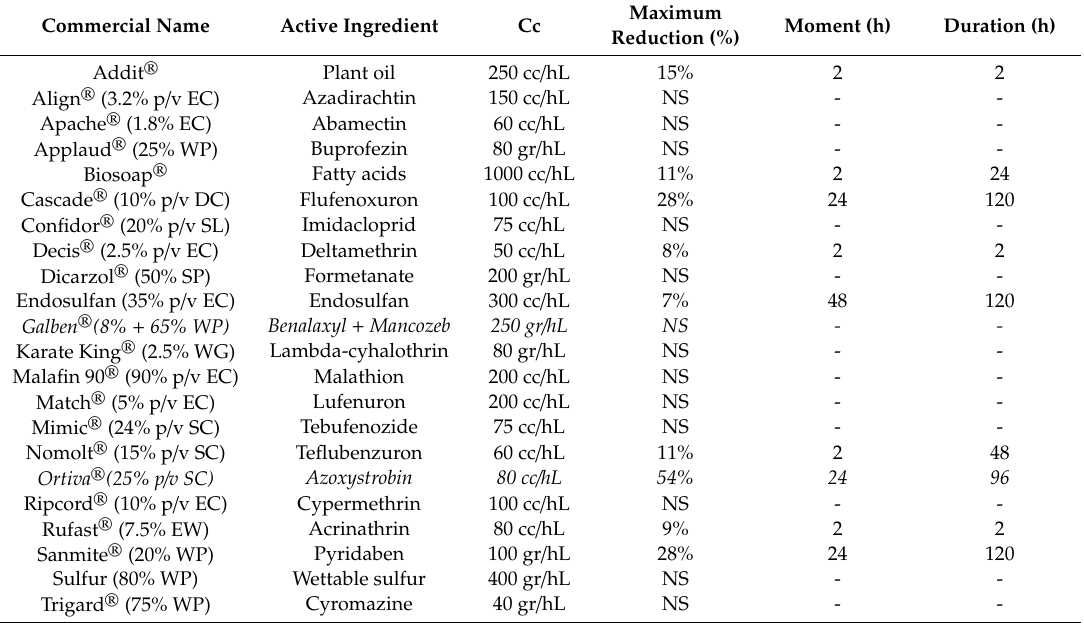
Table 1. List of the studied pesticides (20 insecticides and 2 fungicides (in italics)), and their e ff ects on the photosynthesis rates of sweet pepper